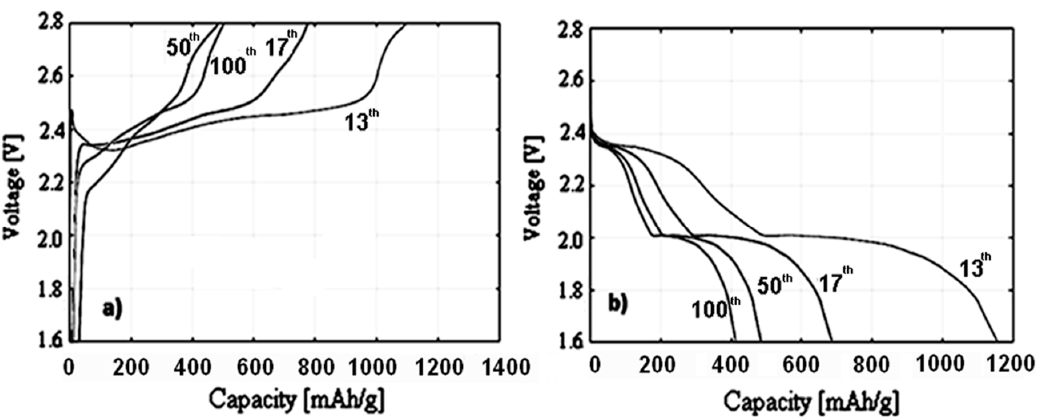
Figure 13. ( a ) Discharge curves obtained at C/10 for 13th, 17th, 50th and 100th cycle and ( b ) charge curves obtained for 13th, 17th, 50th and 100th cycle for core–shell S–TiO 2 materials.